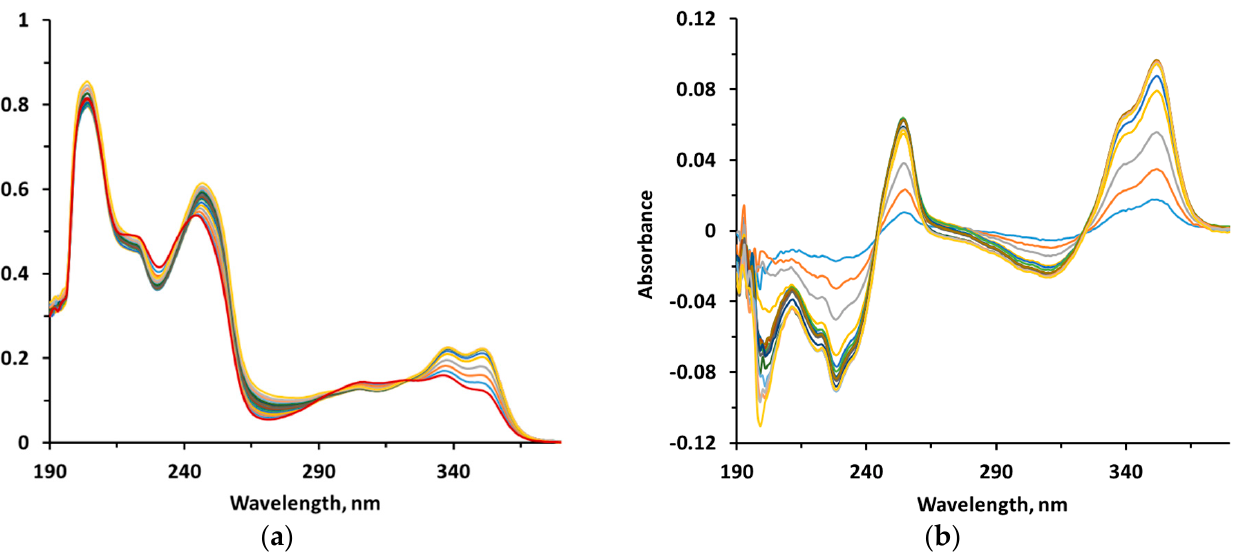
Figure 8. ( a ) UV absorption spectra of 5b (20 µM) in ethanol after addition of increasing concentrations of CuCl 2 (2–34 µM). ( b ) the differential spectra due to the 5b –Cu 2+ complex formation obtained by numerical subtraction from the spectra of the mixture of the spectra of the Cu 2+ alone and 5b alone at the corresponding concentrations.